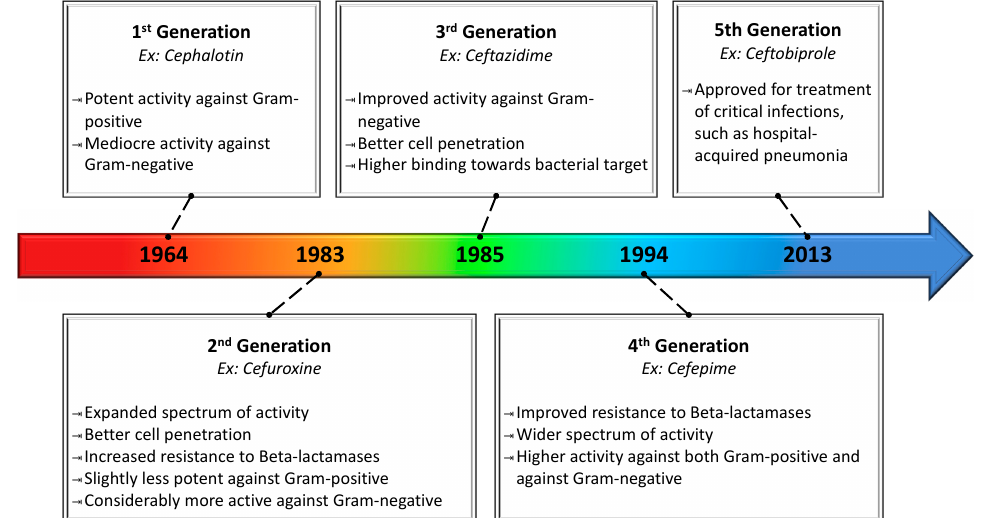
Figure 2. Evolution of cephalosporin characteristics over semi-synthetic generations. Because each generation is the result of adding different molecular groups to 7-ACA, characteristics are not necessarily inherited by succeeding generations. For instance, second-generation cephalosporins had reduced potency against Gram-positive pathogens, despite their otherwise improved properties.